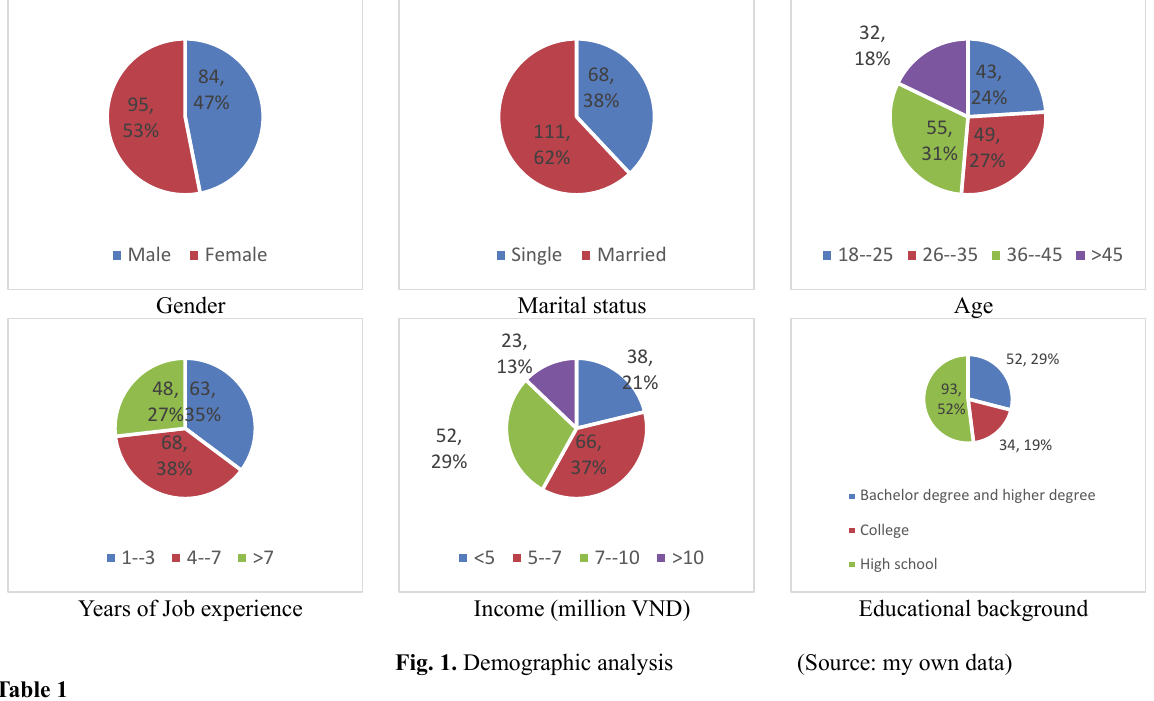
Fig. 1. Demographic analysis (Source: my own data)